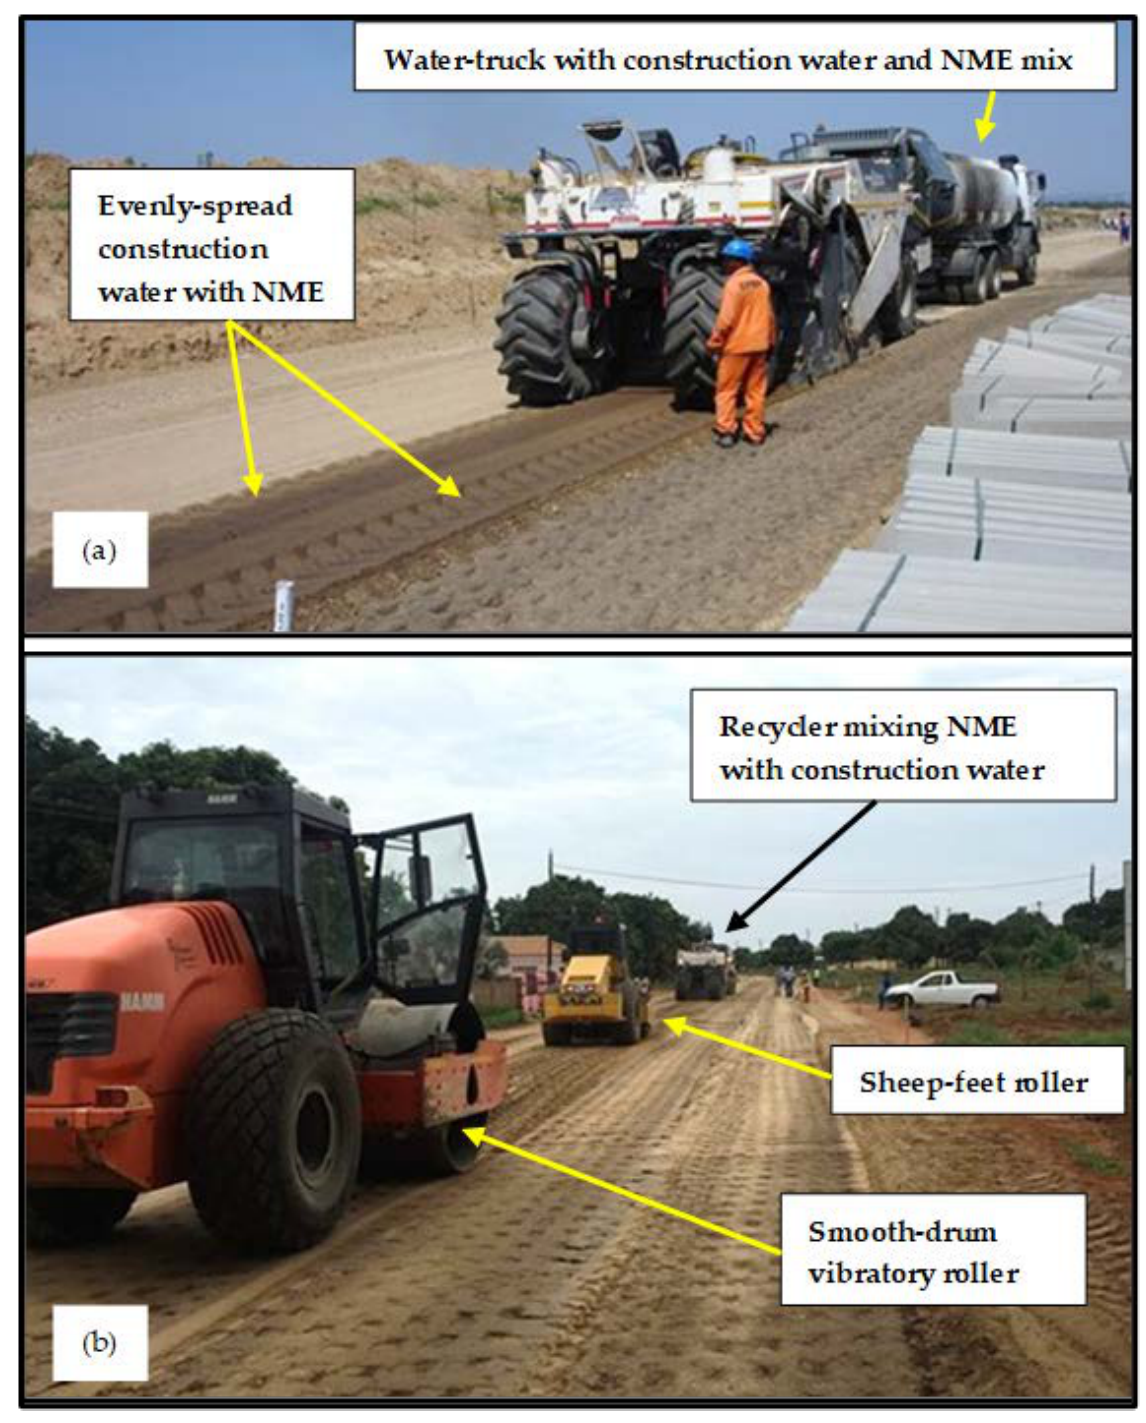
Figure 10. Mixing of the anionic NME stabilising agent using a recycler with a fitted micro-processor which controls the application of the NME stabilising agent pre-mixed with the construction water of the ( a ) inter-city highway. ( b ) Upgrading of urban road.